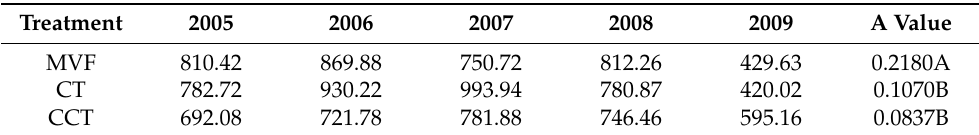
Table 1. Yield (kg/666.7 m 2 ) and A values of different shaping methods measured for five